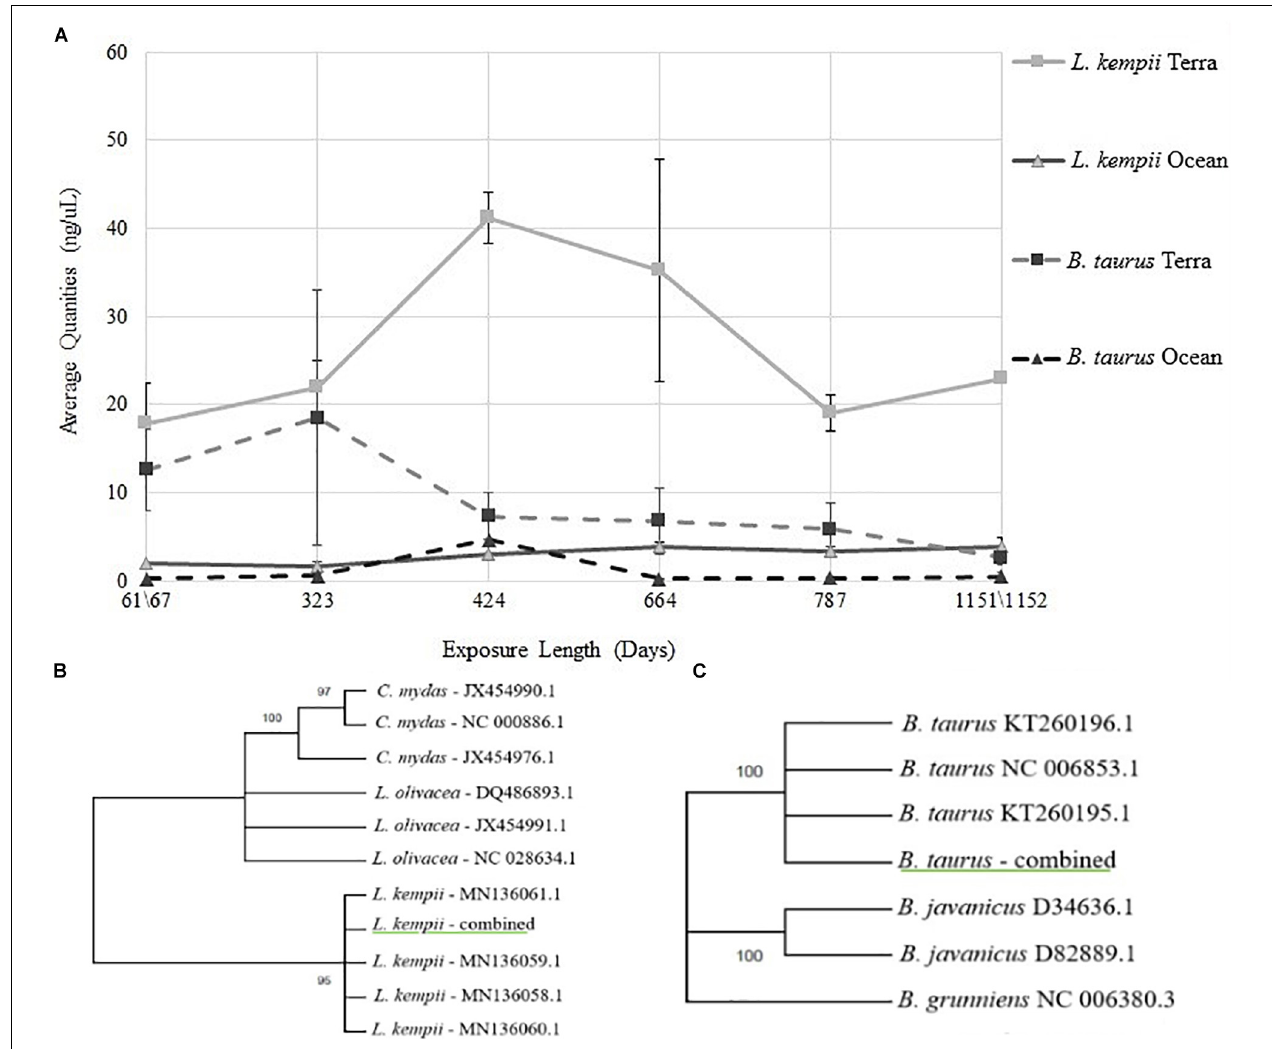
FIGURE 1 | (A) Average DNA quantities recovered from L. kempii and B. taurus bone samples from terrestrial and marine environments over 3-years. DNA extracted from L. kempii and B. taurus bone samples were plotted as a function of exposure length in days ranging from 61/67- to 1151/1152-days. The four experimental conditions represented are L. kempii terrestrial exposure ( L. kempii Terra), L. kempii marine exposure ( L. kempii Ocean), B. taurus terrestrial exposure ( B. taurus Terra), and B. taurus marine exposure ( B. taurus Ocean). Because Pro K and CTII treatment groups demonstrated no statistical differences, all data represented in this figure is the aggregate of both the Pro K and CTII treatment groups. (B,C) Experimental DNA sequences generated from DNA extracted from L. kempii and B. taurus bone are underlined in green. All L. kempii and B. taurus sequence data were consistent no matter the experimental condition or time of exposure; therefore, sequence data for each species was simplified to “ L. kempii —combined” and “ B. Taurus —combined.” Reference sequences used in the construction of all tress are by list genus/species name and then by their GenBank accession number. All trees were constructed using the Hasegawa-Kishino-Yano model; bootstrap values are located at each node. (B) Maximum Likelihood tree for the L. kempii MT-NAD4 genetic marker. (C) Maximum Likelihood tree for the B. taurus MT-CYB genetic